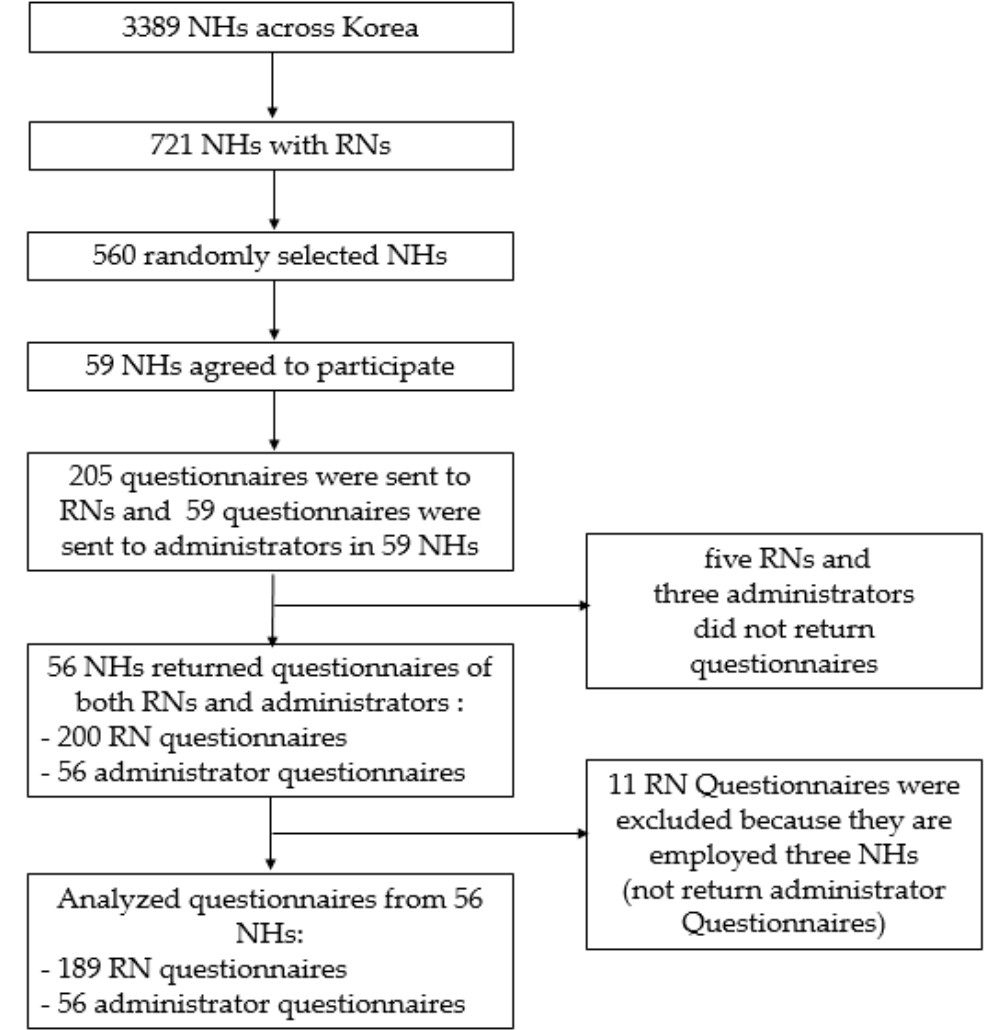
Figure 1. Sampling and participant recruitment.